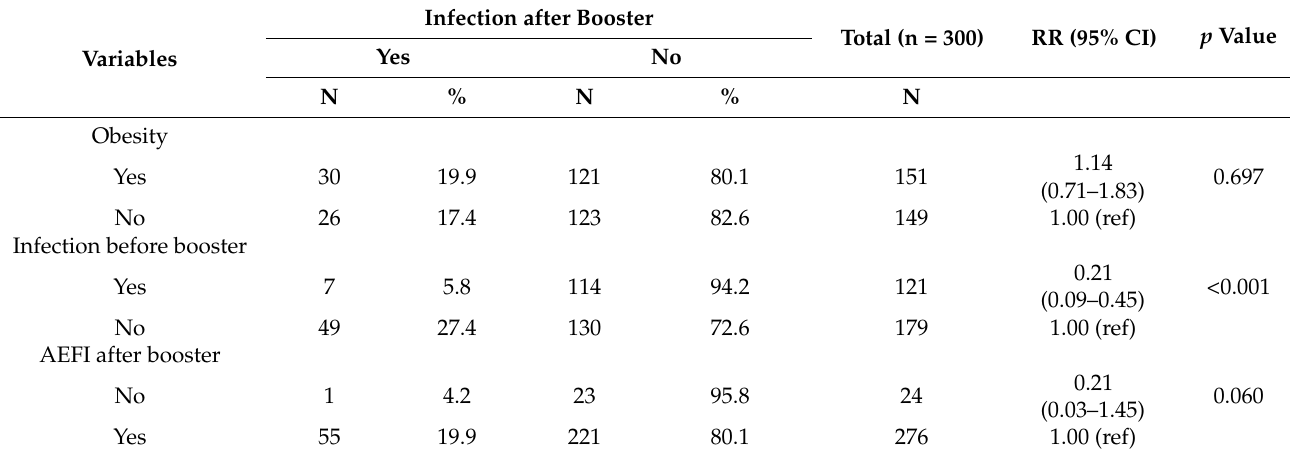
Figure 2. Interval between interview and booster vaccination. This figure shows variation in the time interval between booster vaccination and participants’ interview. The researchers set 5 months as the interval of outcome observation after booster vaccination for equivalence and to avoid bias.